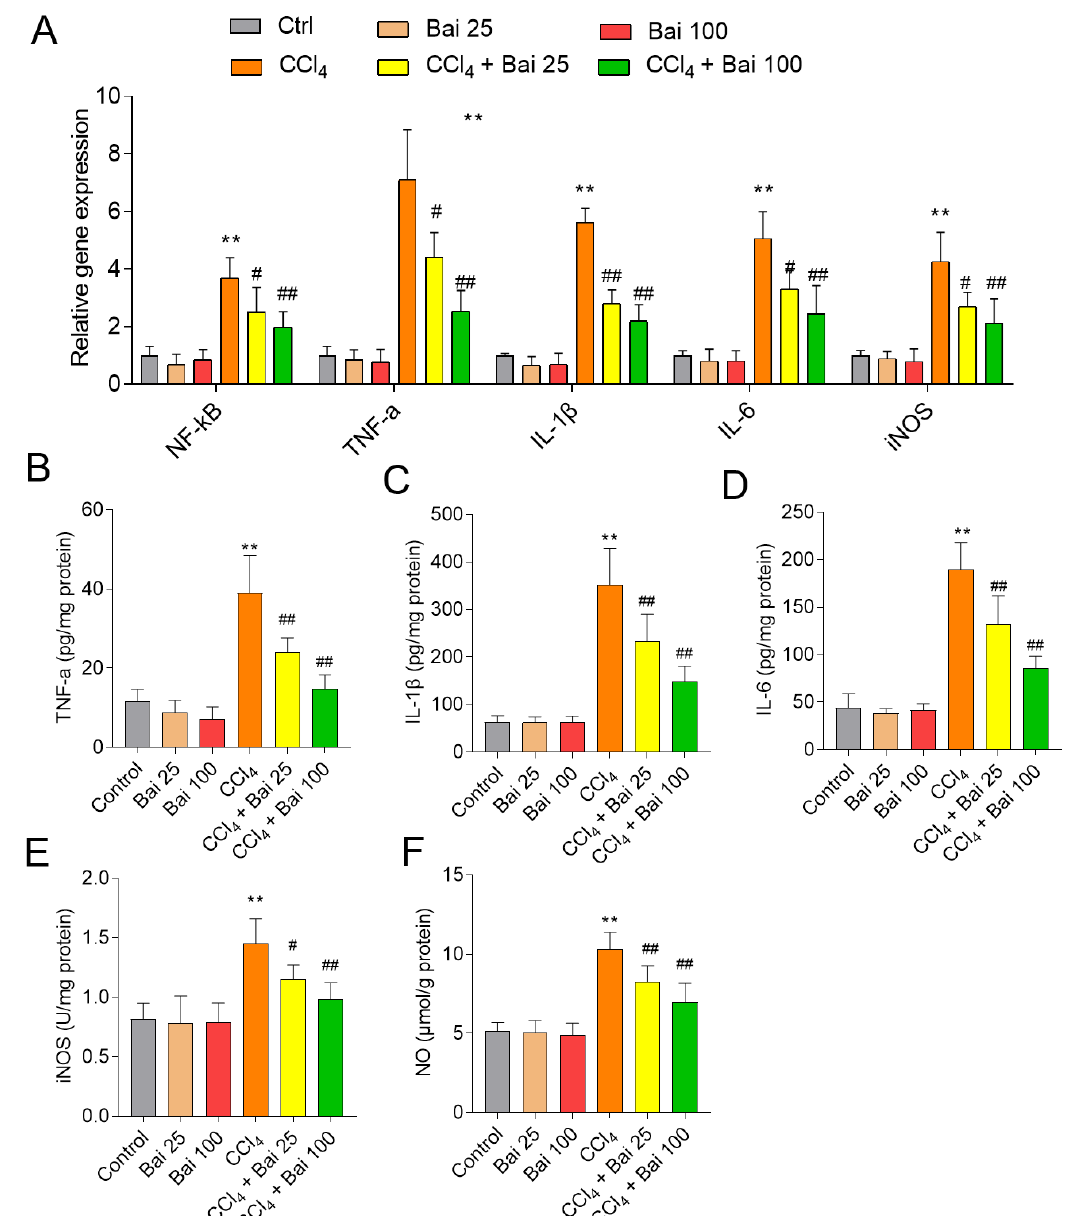
Figure 7. Effects of baicalein supplementation on CCl 4 -induced inflammation in the liver tissues of mice. ( A ) The relative expression levels of NF- κ B , TNF-a , IL-1 β , IL-6 , and iNOS mRNAs; ( B ) levels of IL-1 β protein; ( C ) levels of IL-6 protein; ( D ) levels of TNF-a protein; ( E ) levels of iNOS protein; ( F ) levels of NO. All data are presented as mean ± SD ( n = 6). ** p < 0.01, compared to the control group; # p < 0.05 or ## p < 0.01, compared to the CCl 4 only group. Bai: baicalein.